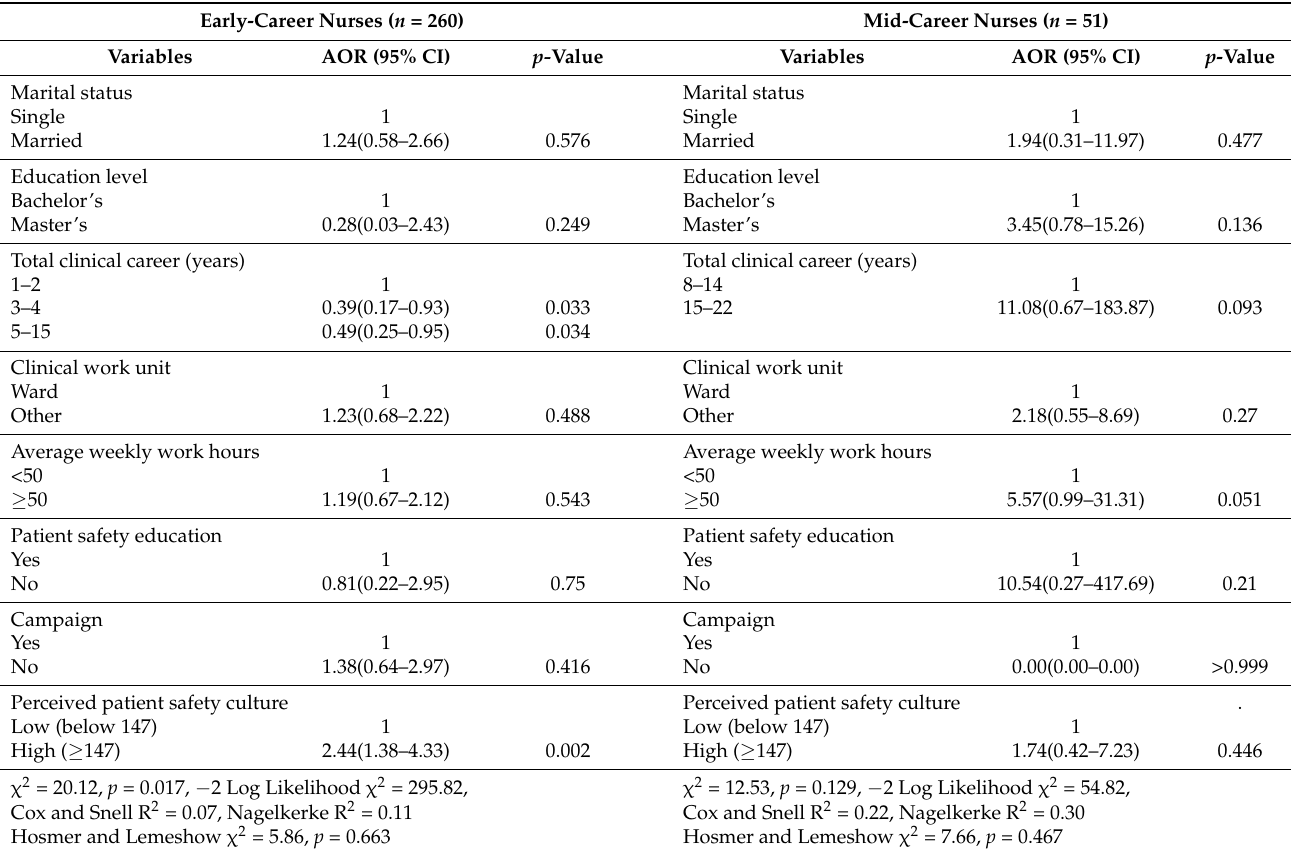
Table 4. Factors influencing appropriate medication error reporting ( n =